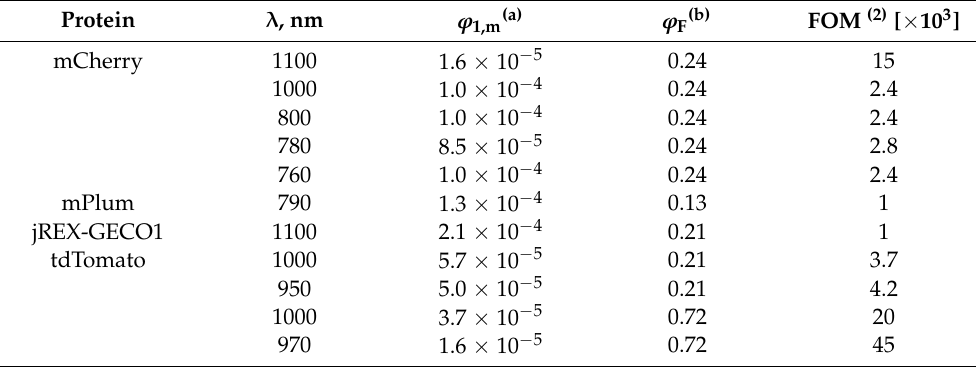
Table 6. Figure of Merit for TPLM applications of FPs showing second-order power dependence of multiphoton bleaching